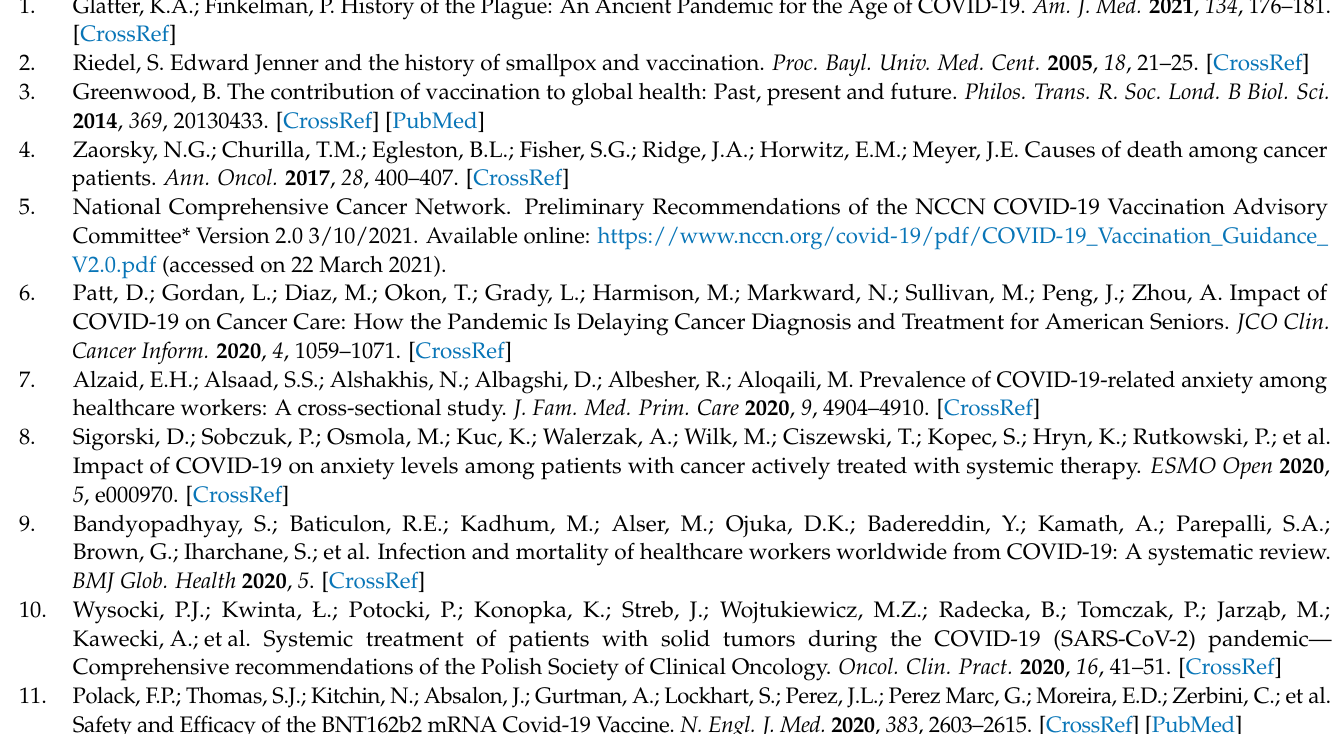
to get vaccinated against COVID-19 (n =